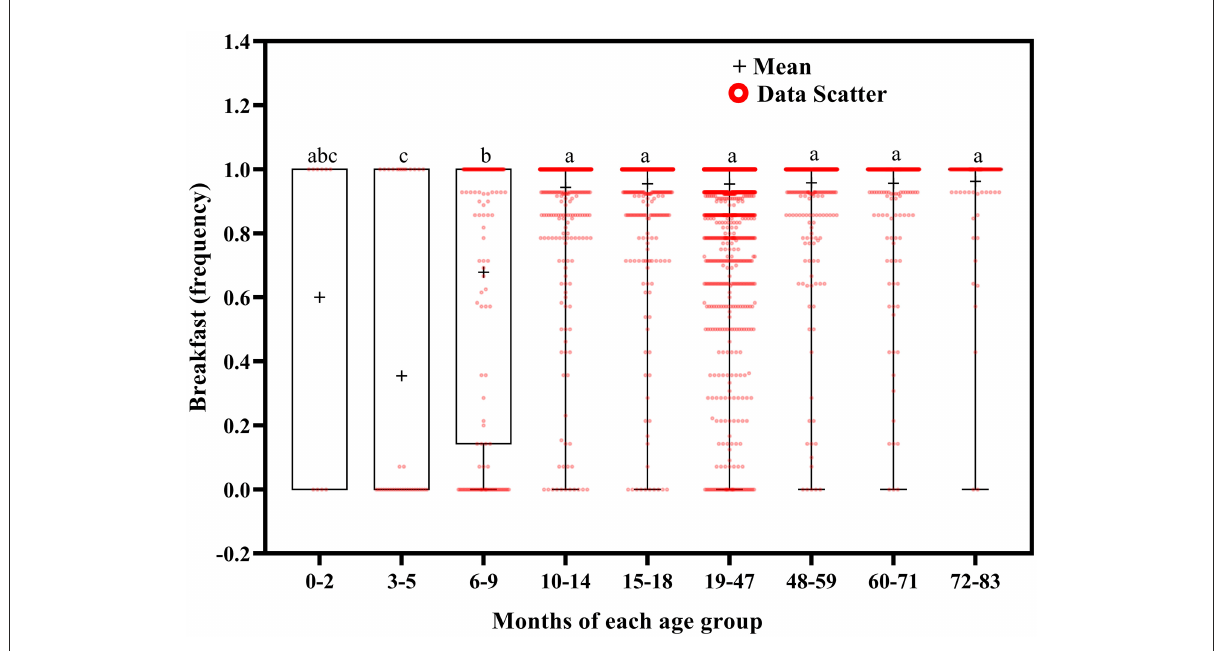
FIGURE10 Results of the one-way ANOVA for breakfast stratified by age.